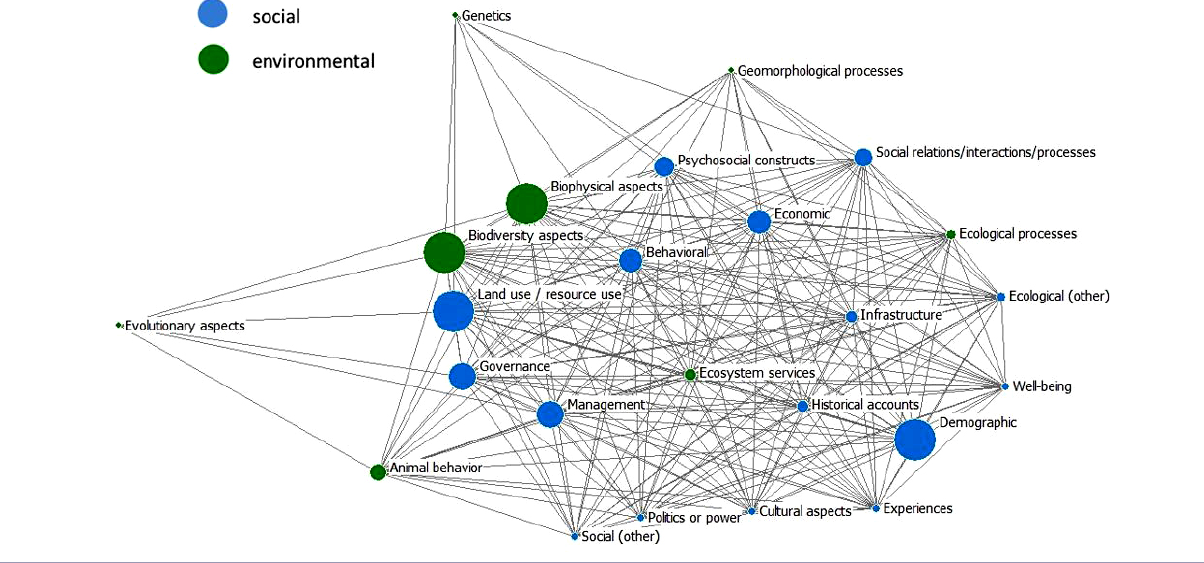
Fig. 1 . Social and ecological variables captured in social-ecological systems (SES) research studies (n = 101 empirical studies) and how they are integrated. The graph was generated using a spring embedding algorithm in the Netdraw software package, which assigns locations to nodes such that nodes with the smallest path lengths are closer together (Krempel 2011). Thus, an aspect placed far from the rest of the network indicates low integration of this aspect into SES research. In addition, the bigger the size of the node, the higher the betweenness score, suggesting that a particular variable is playing an important role in integrating other variables into SES